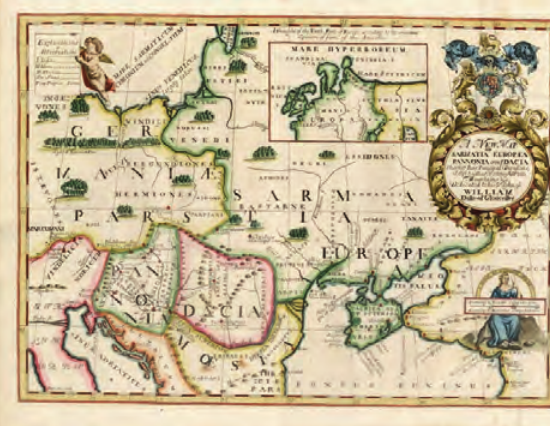
Fig. 7. European Sarmatija and Aziatic Sarmatija in the map